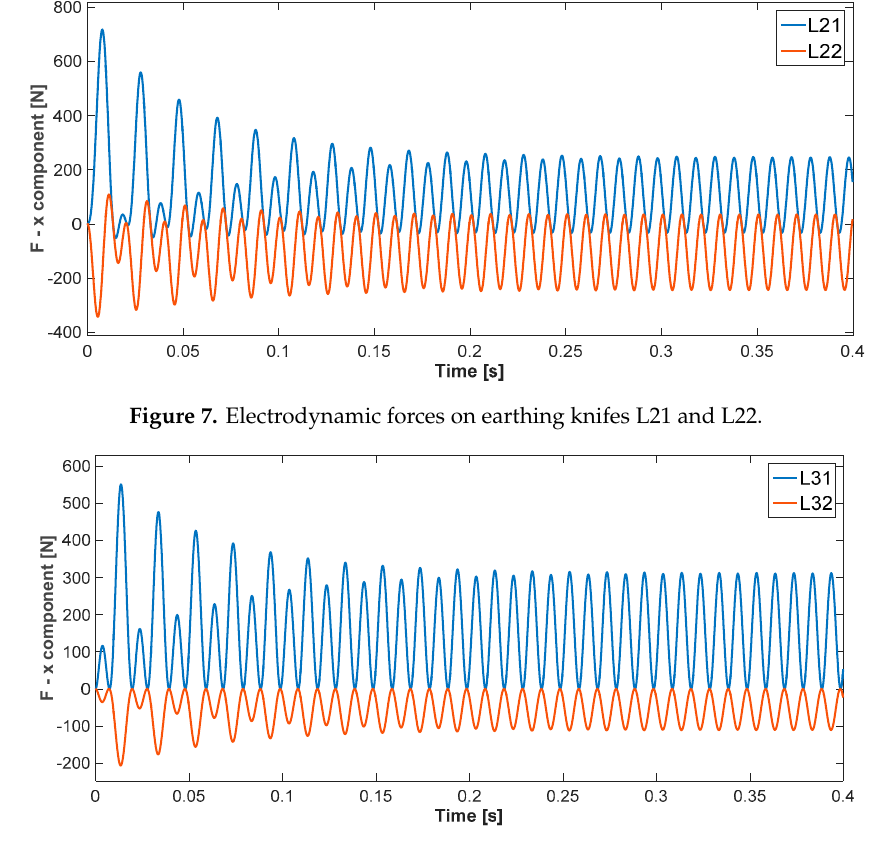
Figure 8. Electrodynamic forces on earthing knifes L31 and L32. Table 3. Maximum forces on knifes in transient and in stationary state.